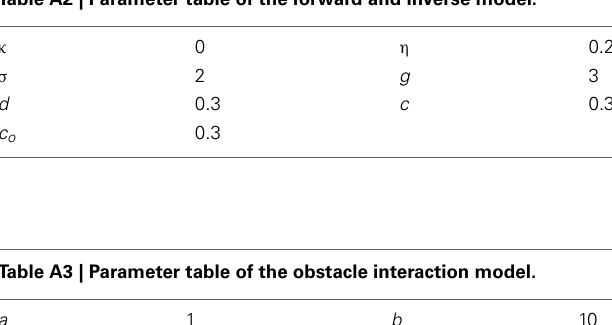
Table A2 | Parameter table of the forward and inverse model.